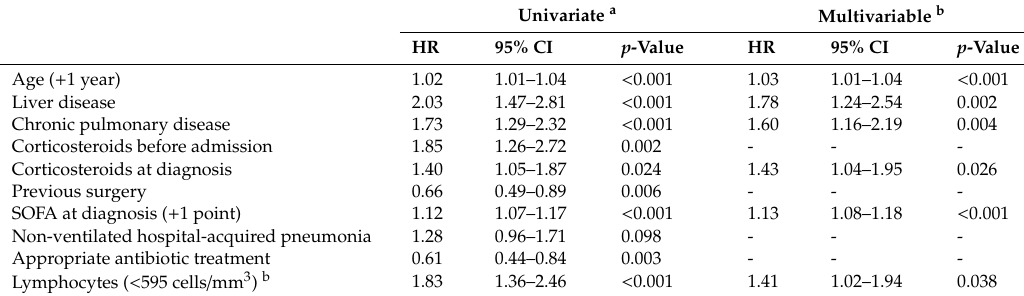
Table 3. Cox regression analyses to predict 90-day mortality in patients with